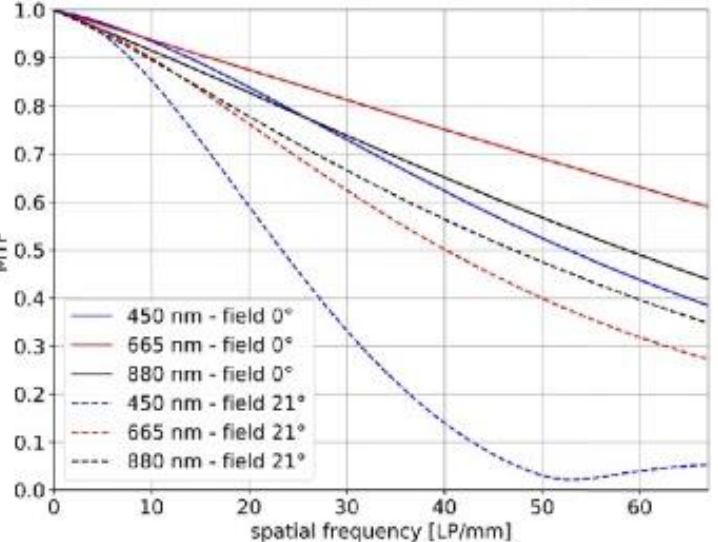
Figure 33. MTF diagrams for three different wavelengths (450, 665, and 880 nm) and two different field positions.